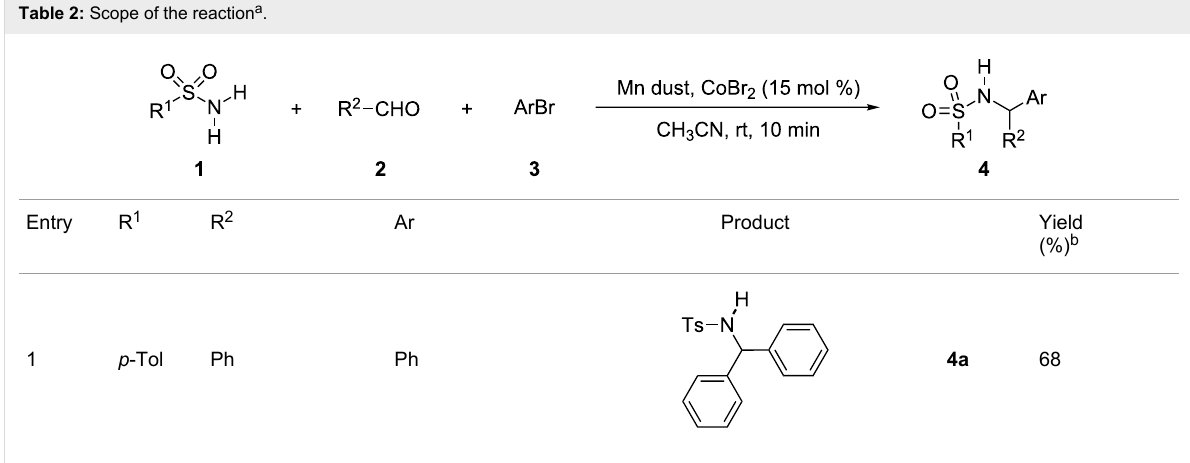
Table 2: Scope of the reaction a